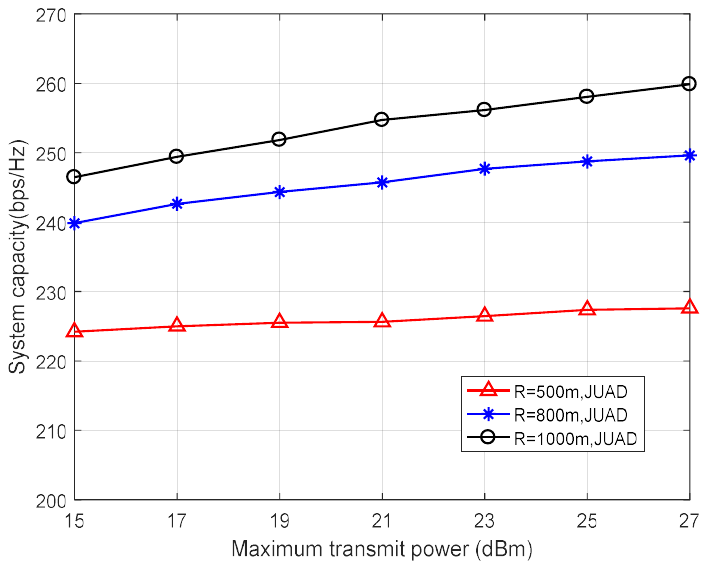
Figure 5. The system capacity versus different maximum transmission power with different cell radius.